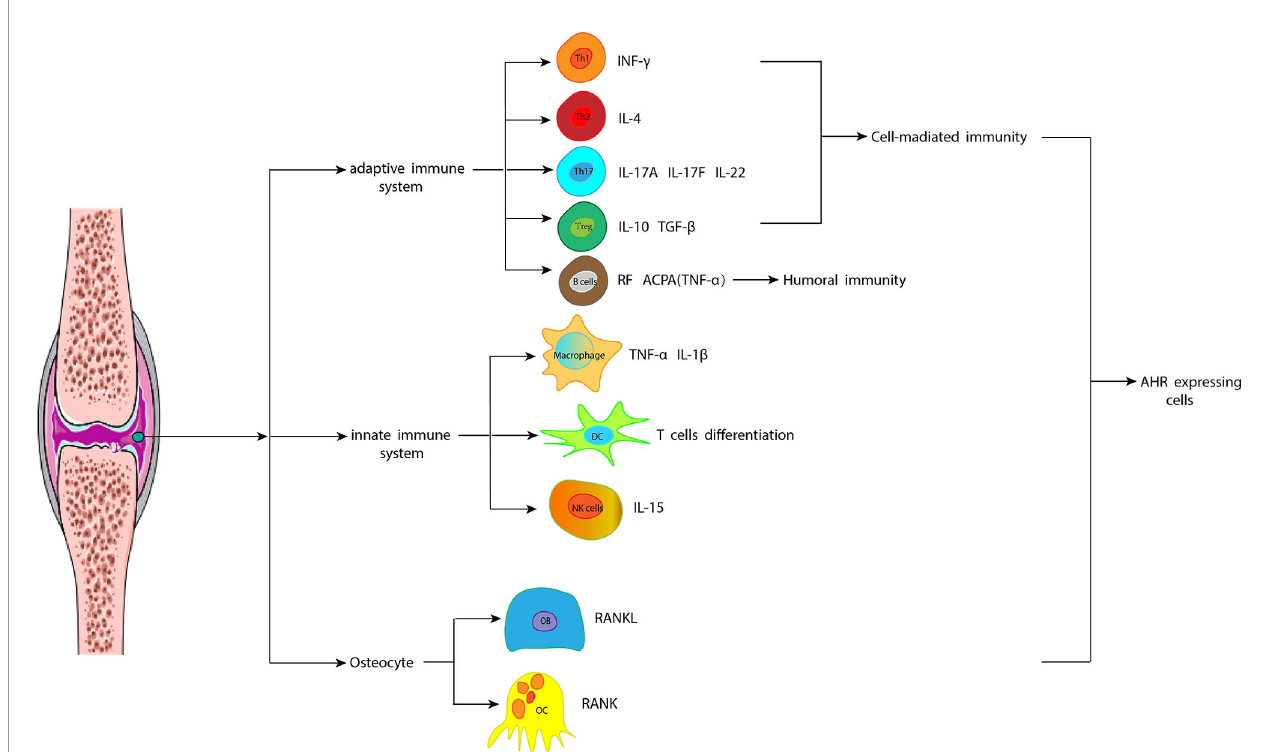
FIGURE 3 | Different cells and their cytokines CKs play a key role in the development of RA through the AHR signaling pathway. The articular cavity is in fi ltrated by many in fl ammatory cells, which produce a mass of in fl ammatory mediators and induce an in fl ammatory cascade. These in fl ammatory cells include cells of the innate immune system, such as macrophages, dendritic cells, and natural killer cells, as well as T cells and B cells of the adaptive immune system. Additionally, reduced osteoblasts and increased osteoclasts lead to the destruction of subchondral bone, leading to the degeneration of articular cartilage. CKs, cytokines; RA, rheumatoid arthritis; AHR, aromatic hydrocarbon receptor; IFN- g , interferon- g ; IL, interleukin; TGF- b : transforming growth factor- b ; RF, rheumatoid factor; ACPA, anti-citrullinated protein antibody; TNF- a : tumor necrosis factor- a ; NK, natural killer; OC, osteoclast; RANKL, receptor activator of NF- k B ligand; OB, osteoblast; RANK, receptor activator of NF- k